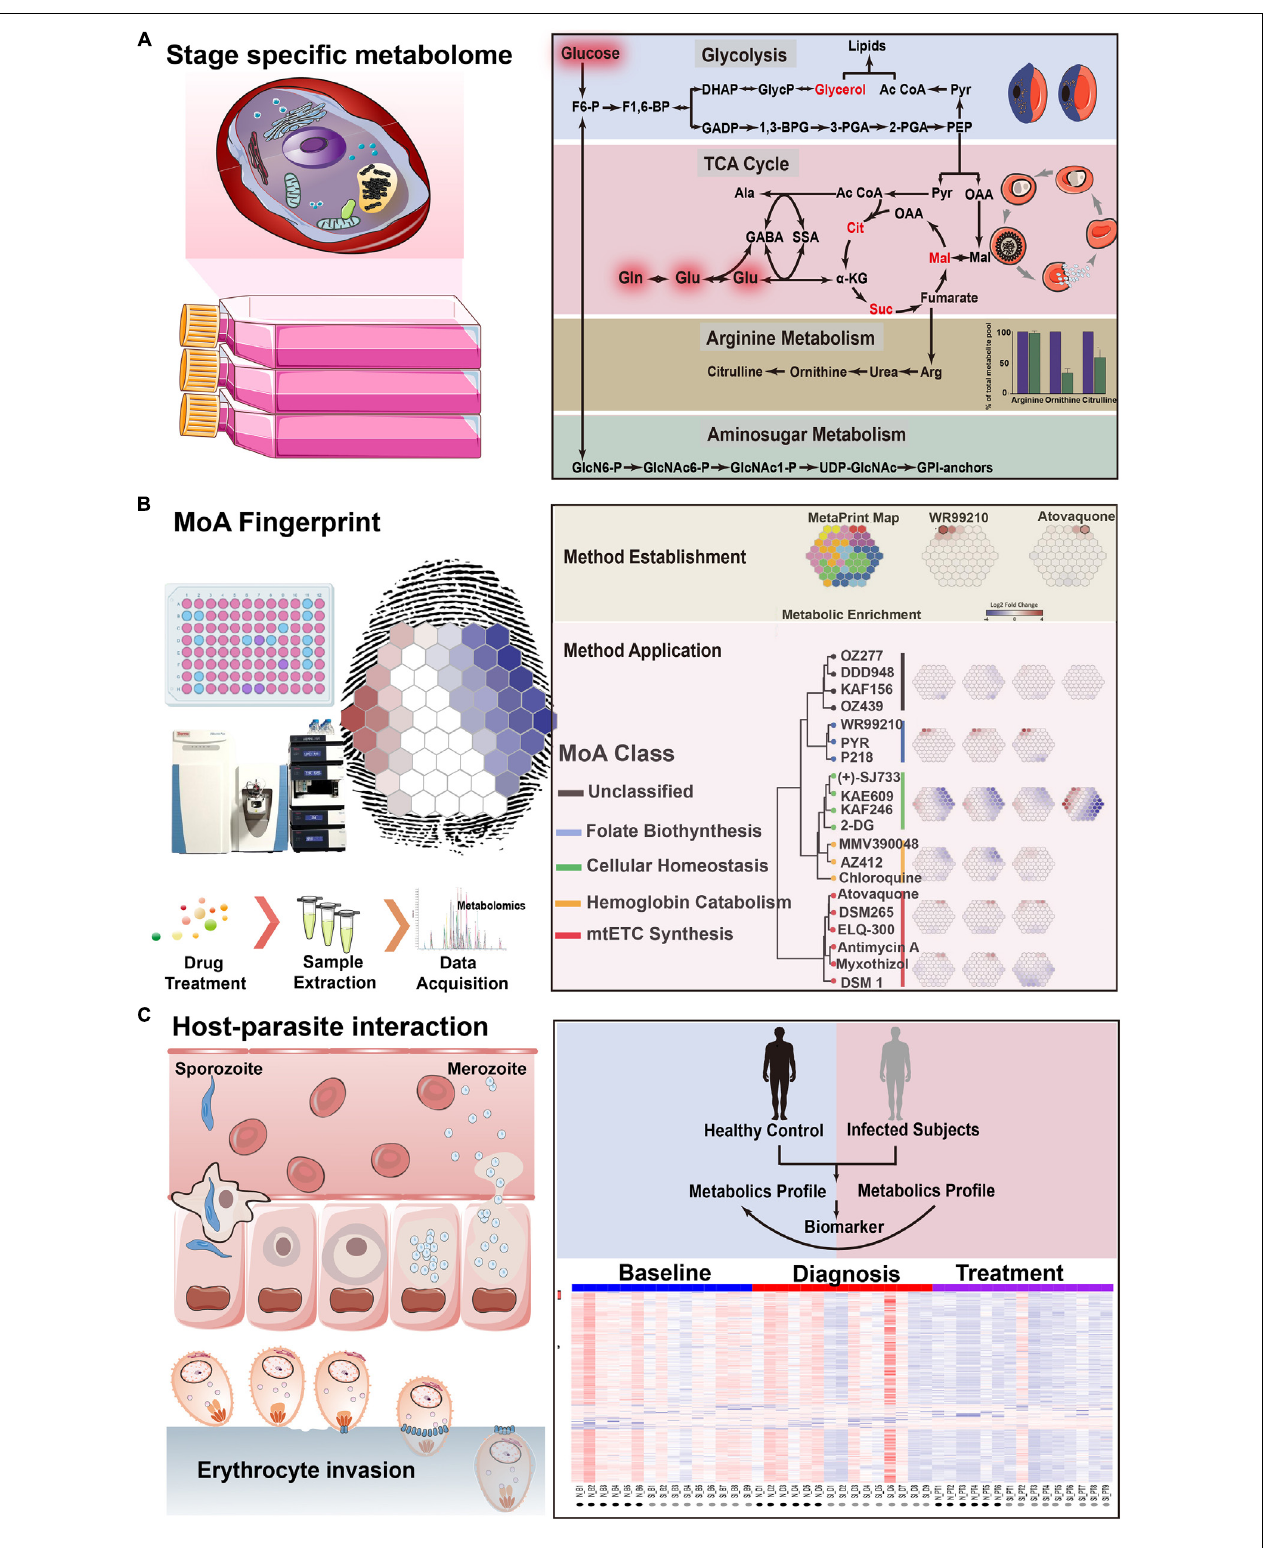
FIGURE 3 | Metabolomics highlights in applications for Plasmodium spp. biology . (A) An integrated map of an affected metabolic network of Plasmodium during different life cycle stages. (B) Investigation of antimalarials metabolic fingerprints and mode of action of validated compounds with antimalarial activity. (C) Exploration of the link between host response and parasite metabolic plasticity during infection. The copyright of adapted figure has been achieved.